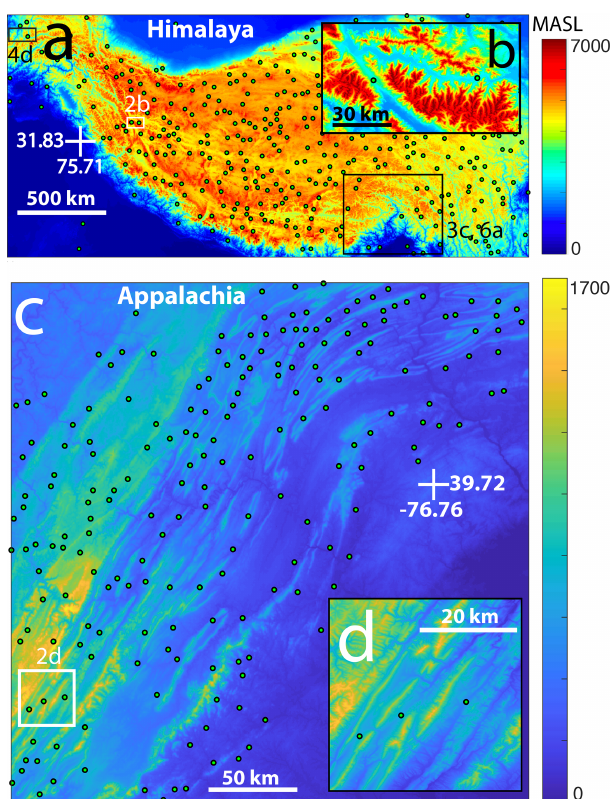
Figure 2. Wind gaps in tectonically influenced areas. (a) A map of estimated wind-gap locations (yellow circles) in the Himalaya. Boxes mark the regions shown in other figures, and figure num- bers are specified next to each box. (b) A zoom into the section of the map marked 2b in panel (a) , showing a more detailed view (using an SRTM DEM; Farr et al., 2007) of wind-gap locations. Here, the color bar represents the range of elevations between 3500 and 6000m. (c) A map of estimated wind-gap locations in the Ap- palachian fold-and-thrust belt. (d) A zoom into the section of the map marked 2d in panel (c) , showing a more detailed view (us- ing an SRTM DEM; Farr et al., 2007) of wind-gap locations. Here, the color bar represents the range of elevations between 450 and 1500m. Color schemes were selected to highlight the specific to- pography of every region. Wind-gap locations were identified over GMTED DEMs (Danielson and Gesch, 2011) and are only a subset of all wind gaps in these regions. The procedure used for automated wind-gap identification is described in the Supplement.